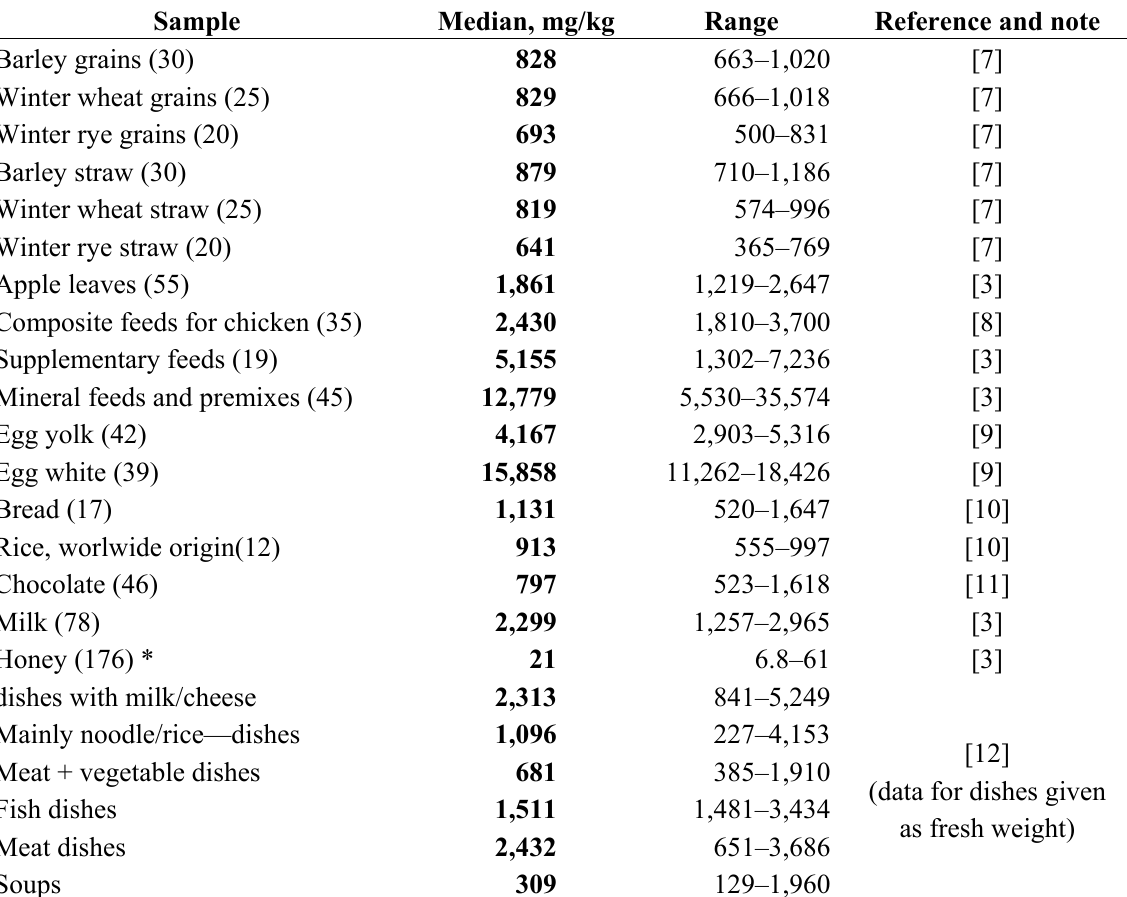
Table 2. Occurrence of sulfur in green plants, feed and food (mg/kg dry mass) in Austria. The number of samples is given in brackets. Cereals have been investigated at 3 experimental sites in Lower